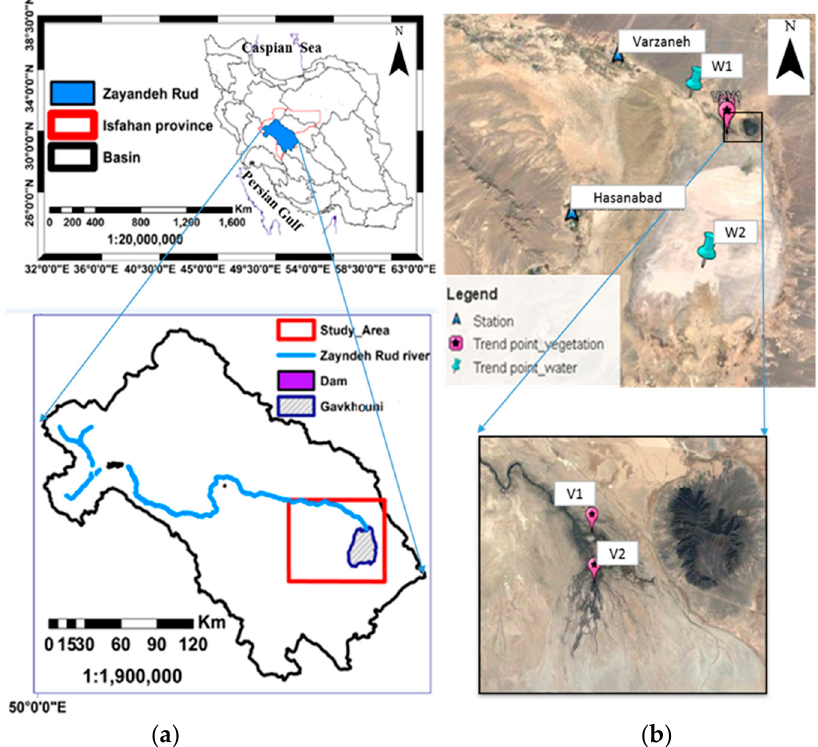
Figure 1. ( a ) Location of the Gavkhouni wetland and the study area (red boundary) in the Zayandeh- Rud River Basin, Isfahan province, Iran; ( b ) two meteorological stations and the selected points (W1–W2, V1–V2) for trends of dryness and vegetation cover.